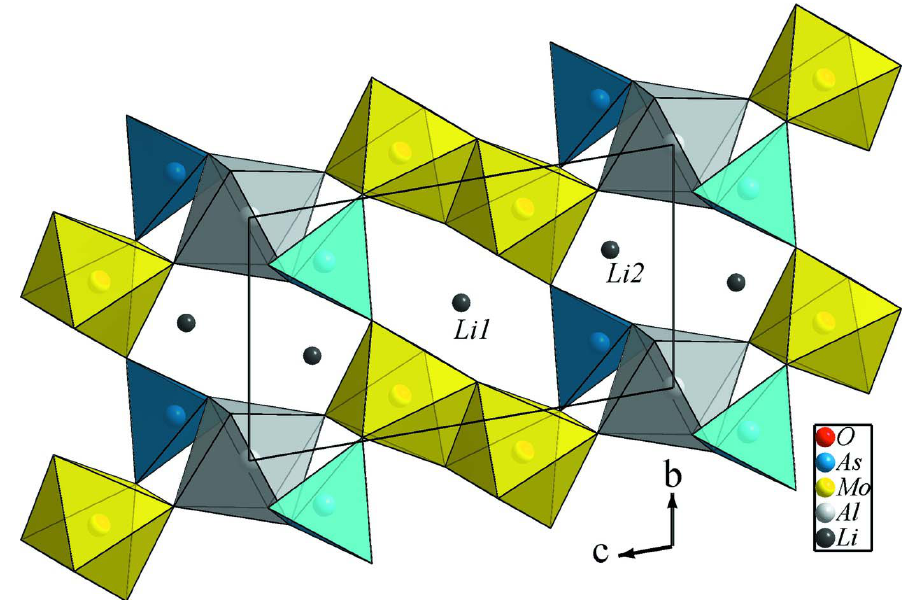
Figure 2 Projection de la structure de Li